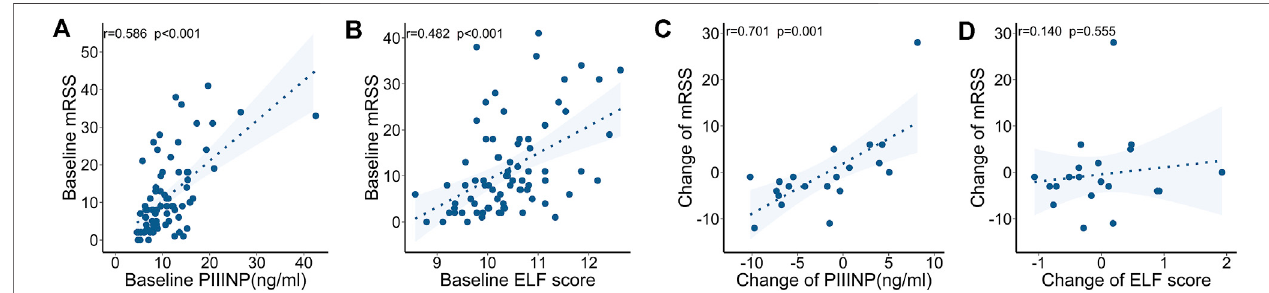
FIGURE2| CorrelationsbetweenserumcollagenmarkersandmRSSatbaselineandduringfollow-up. (A) SerumPIIINPandmRSSatbaseline. (B) ELFscoreand mRSS at baseline. (C) Change in PIIINP and change in mRSS over time. (D) Change in ELF score and change in mRSS over time.